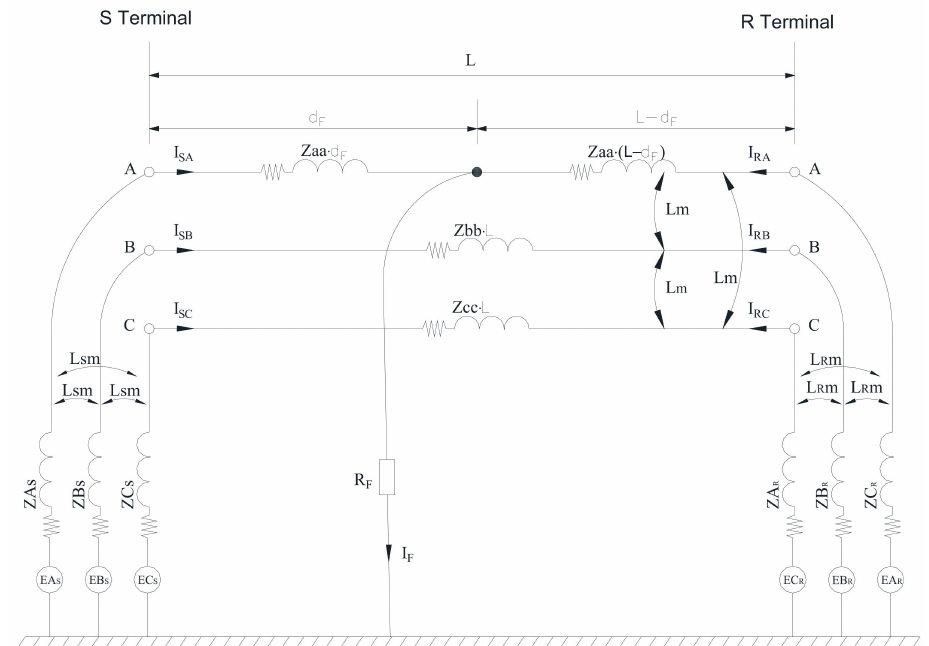
Figure 1. A transmission line with a phase A to ground fault.